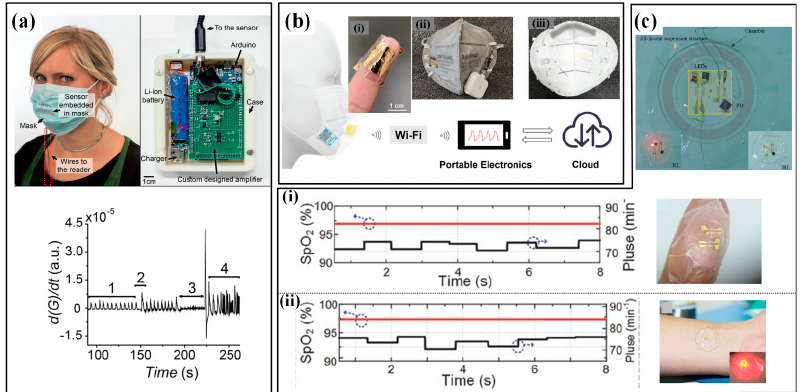
Figure 13. The wearable respiration sensors: ( a ) the face mask with a paper capacitive moisture sensor and corresponding circuit for recognizing breath patterns [144] ; ( b ) smart face mask based on a self-powered ultrathin pressure sensor for wirelessly monitoring breath. (i) is the ultrathin sensor twining one a finger; (ii) and (iii) are the front and back sides of the smart face mask [33] ; ( c ) epidermal inorganic optoelectronic SpO 2 sensor and results measured from fingertip (i) and wrist (ii) [148] . Reproduced with permissions from Wiley (2022)[33]. Reproduced with permissions from Wiley (2016)[144]. Reproduced with permissions from Wiley (2017)[148].